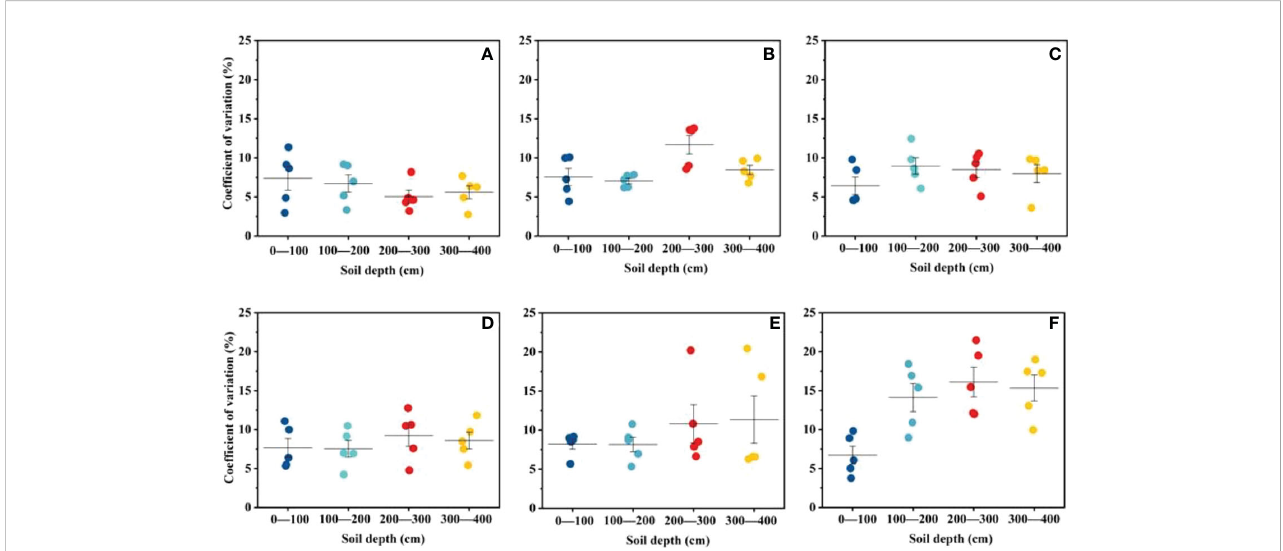
FIGURE 2 A scatterplot of SWC coef fi cient of variability for each soil layer in HA plantation forested land at different ages: (A) wasteland, (B) 5, (C) 11, (D) 22, (E) 34 and (F) 46 years. Different colors represent different soil depths: blue (0-100 cm), green (100-200 cm), red (200-300 cm), yellow (300-400